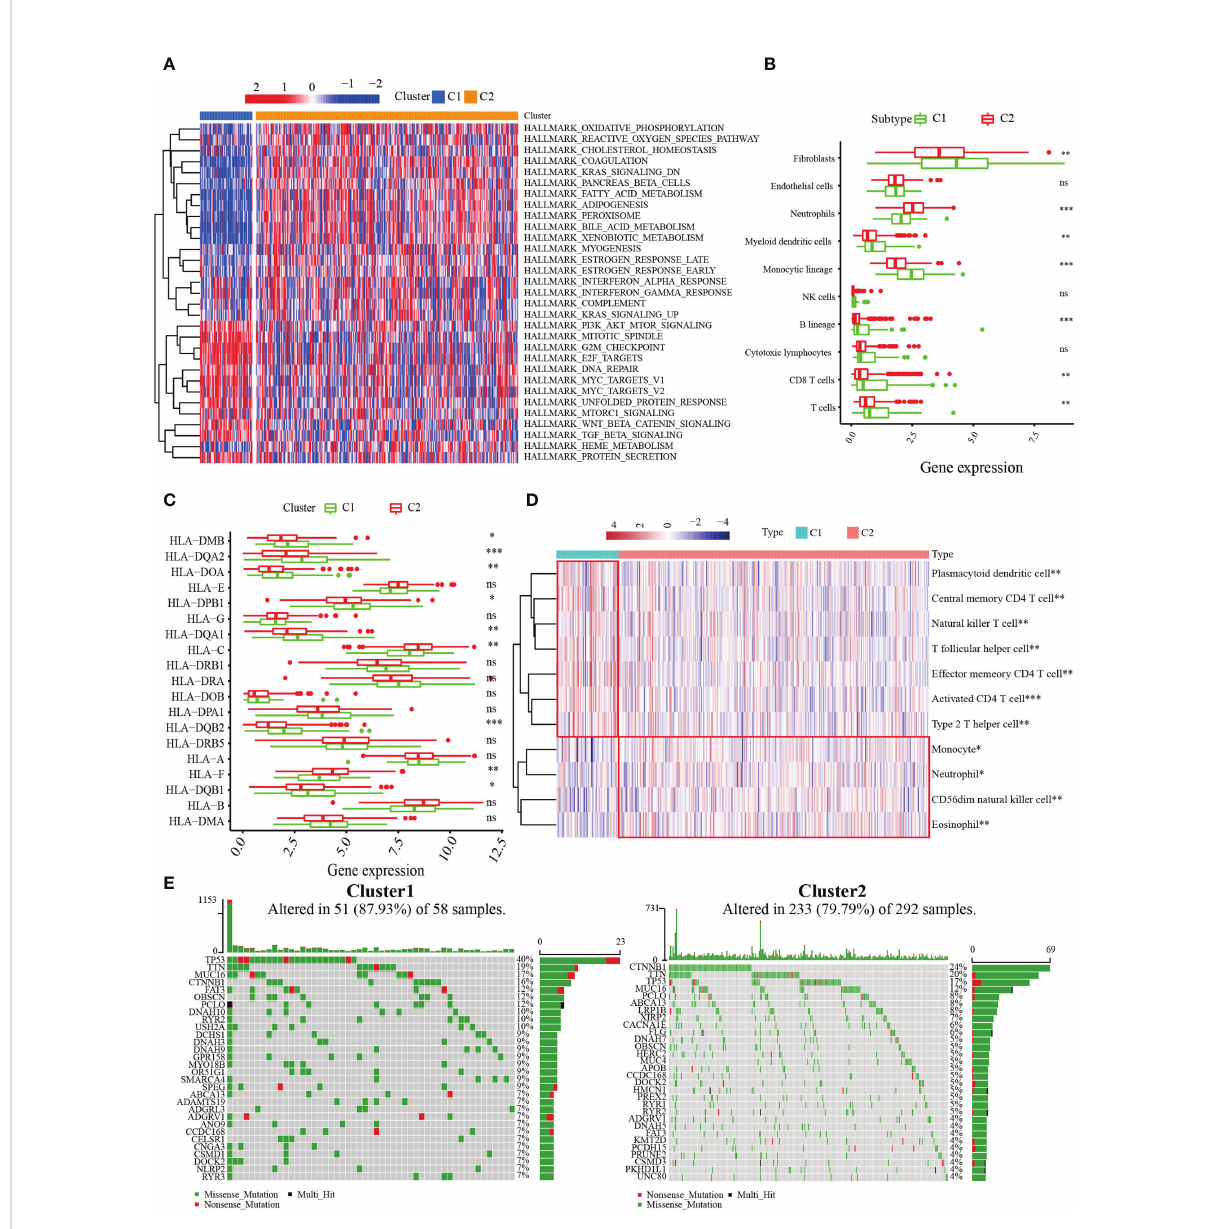
FIGURE 3 Correlation between MARCH ligase-related patterns and the tumor immune microenvironment (TIME). (A) Heatmap of GSVA results. (B) The difference in TIME composition. (C) Differential expression levels of HLA-related genes between the C1 (green) and C2 (red) groups (ns = not signi fi cant, * p < 0.05, ** p < 0.01, *** p < 0.001). (D) Heatmap showing the relative abundances of 11 immune-in fi ltrating cell subpopulations. (E) The 30 genes with the highest mutation rates of C1 and C2 in waterfall